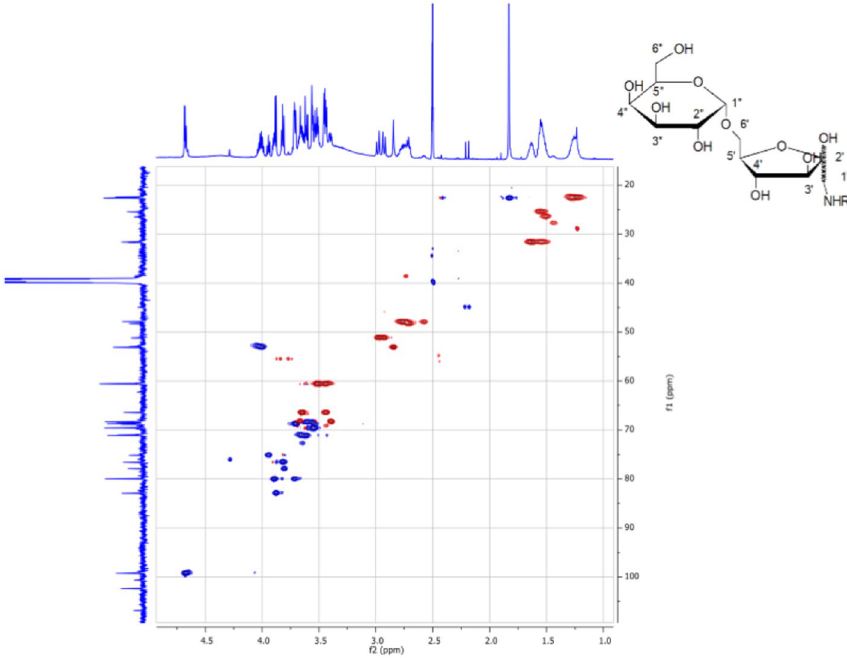
Figure 7. NMR spectrum of the LMW product formed from melibiose and N -α-acetyl-lysine. The inset shows the solved structure of the novel MAGE product.